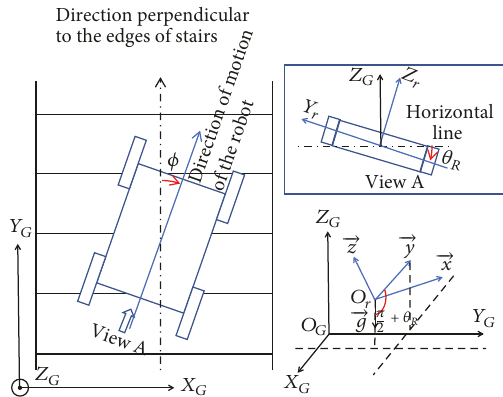
Figure 9: Vertical climbing direction and orientation of the